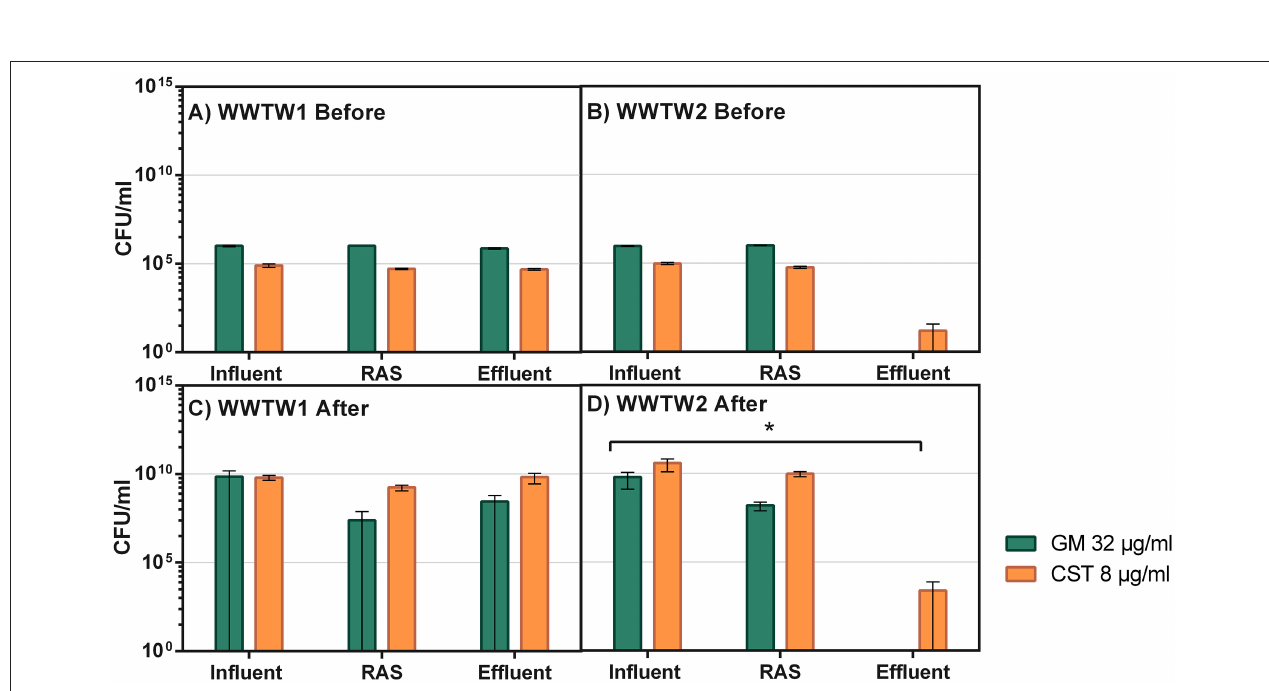
FIGURE 3 | Viable bacterial cells in the presence of GM (32 µ g/ml) and CST (8 µ g/ml) from influent, RAS, and effluent samples in two WWTW [WWTW1: (A,C) , WWTW2: (B,D) ] in sampling event 2 before (A,B) and after (C,D) being enriched in antibiotics. Significant differences ( p < 0.0.5) between matrices are indicated by the black bar and asterisk